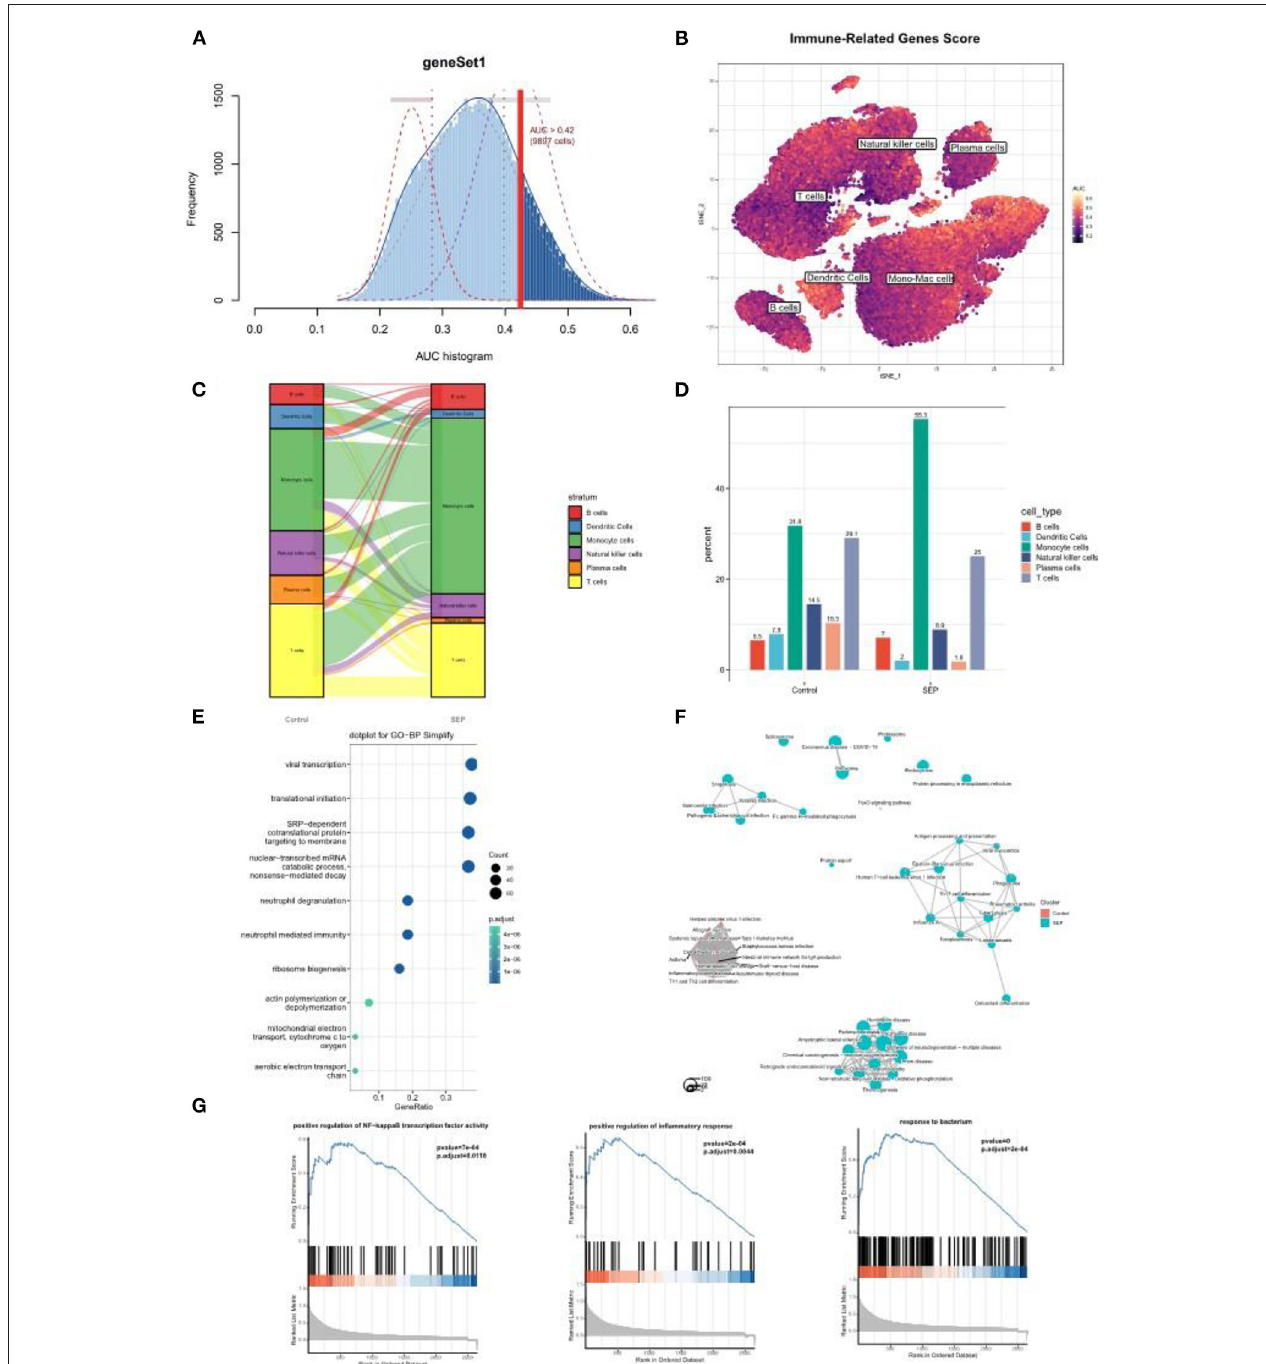
FIGURE 6 | Single-cell analysis revealed a prominent monocyte/macrophage infiltration in sepsis patients. (A) The threshold for distinguishing gene set active cells was set at 0.42. (B) t-SNE plot of the immune-related genes score (IRGs score) in all of the cell types. The dendric and monocyte/macrophage cells (in yellow color) exhibited a higher IRGs Score. (C,D) Sankey diagram and histogram showed the proportion of monocyte/macrophage cells was significantly increased in the patients with sepsis. (E–G) GO and/or GSEA showed that the monocyte/macrophage clusters were mostly enriched in the proinflammatory and infection-related pathway. t-SNE, t-distributed stochastic neighbor embedding; GO, Gene Ontology; GSEA, gene set enrichment analysis.